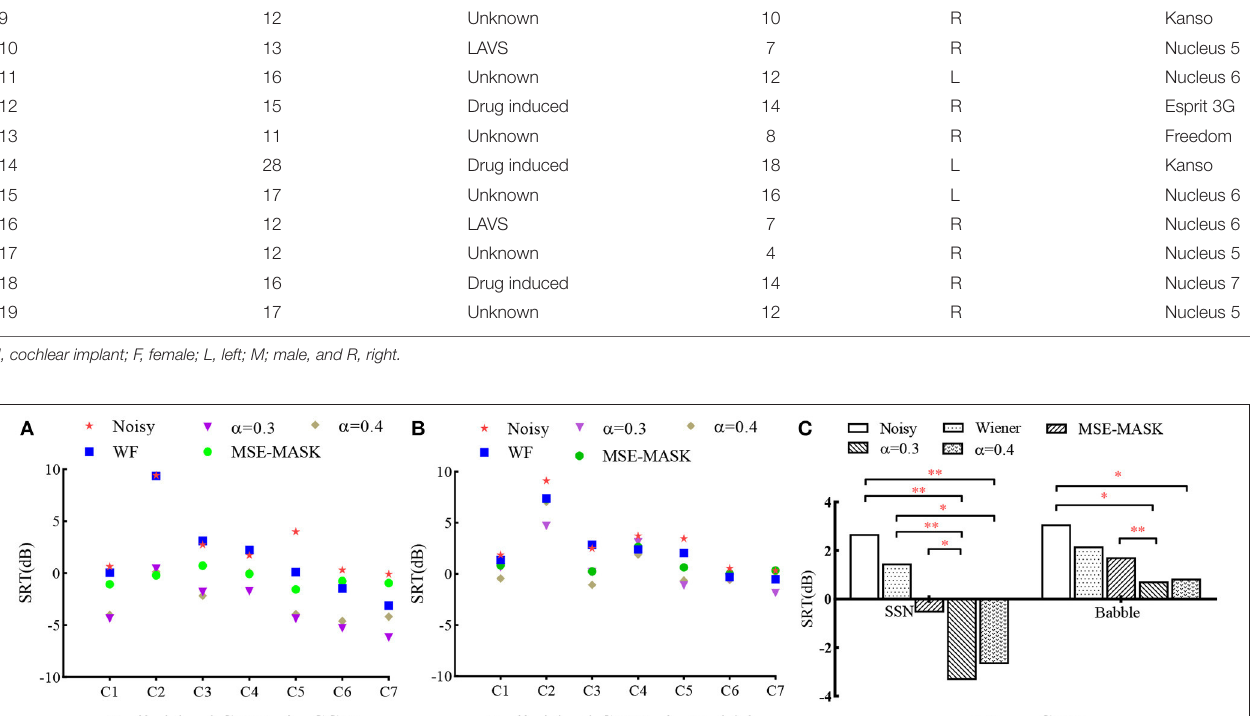
speech recognition test to investigate how the trading-off weight α can maximize the SE gain for CI recipients in different noise